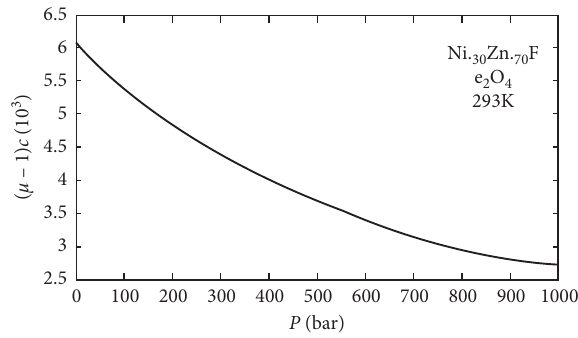
Figure 2: Piezomagnetic curve of Ni-Zn ferrite.